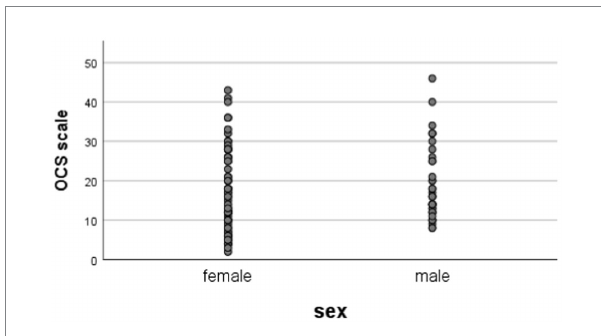
FIGURE 1 Gender distribution of obsessive–compulsive symptoms ( p >